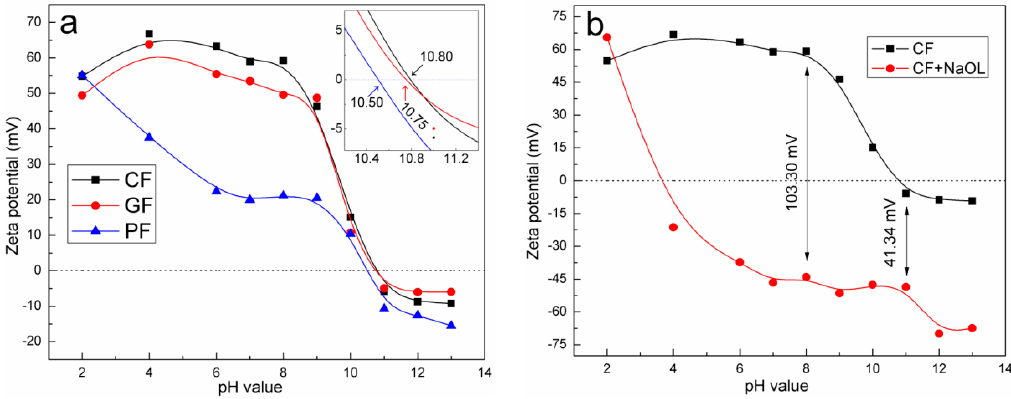
Figure 8. Cont. Figure 8.